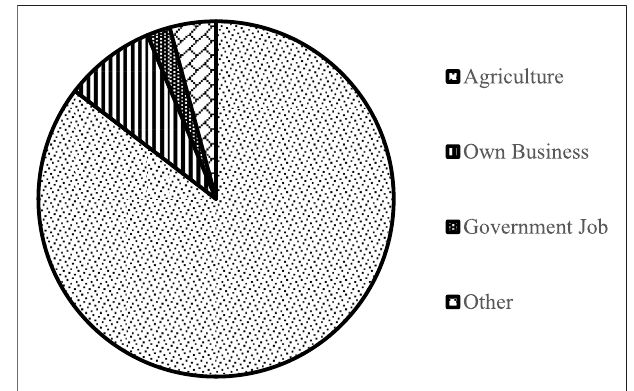
FIGURE 1 | Major sources of income of individuals interviewed from Meenangadi.